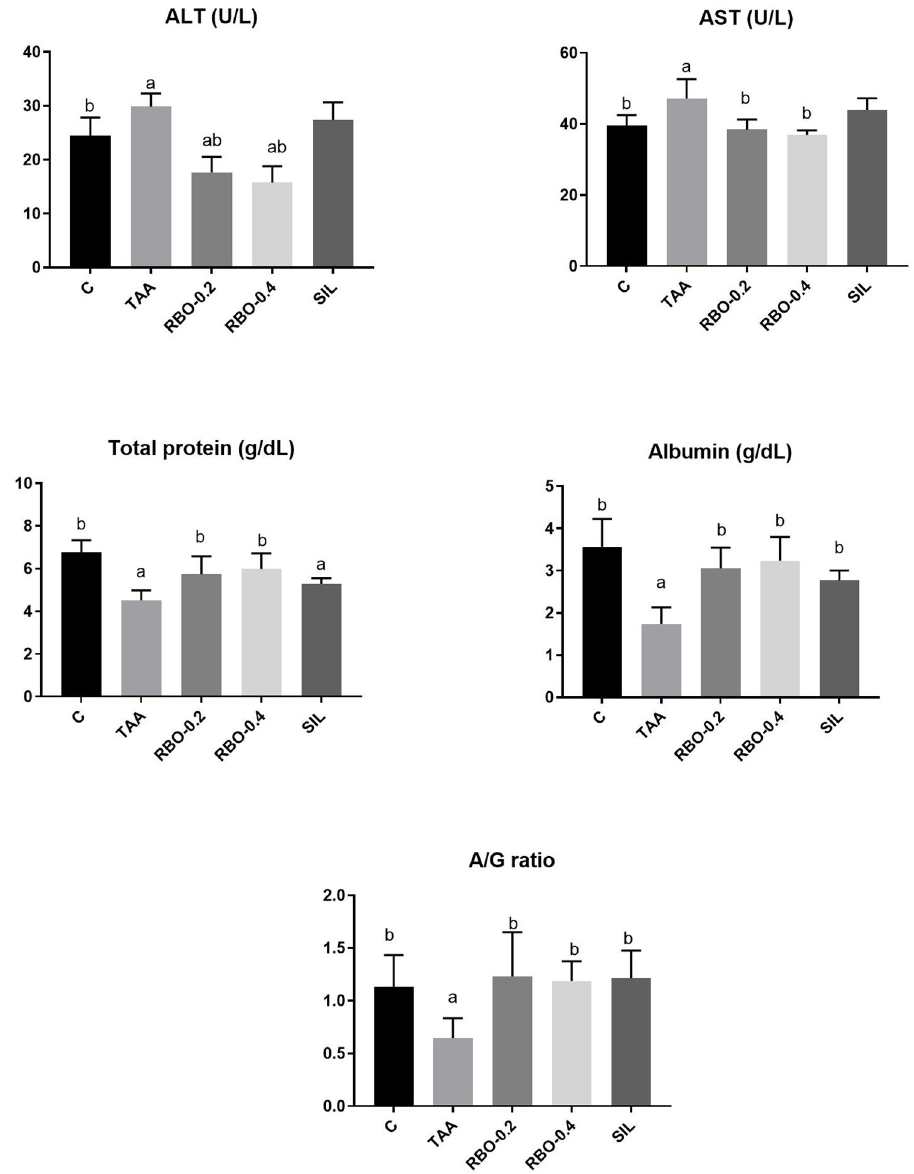
Fig 2. Effect of RBO on serum levels of ALT, AST, total protein, albumin and A/G ratio in TAA-induced liver fibrosis in rats. Control rats, treated with saline; TAA rats, treated with thioacetamide (100 mg/kg; three times per week for 2 weeks, ip ); RBO rats, treated with TAA and RBO (0.2 and 0.4 mL/rat; daily for 2 weeks, po ) and silymarin (100 mg/kg, po ). All data are presented as Mean ± SEM, (n = 6). a P � 0.05 was assumed to denote statistical significance compared to the negative control, b P � 0.05 was assumed to denote statistical significance compared to TAA group. TAA, Thioacetamide; RBO, Rice bran oil; A/G, Albumin/Globulin.